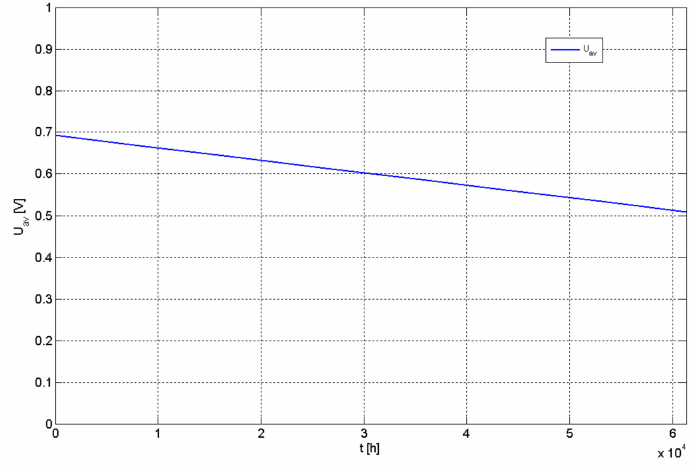
Figure 4. Decline of the average voltage of the PEM-type fuel cell stack [32].